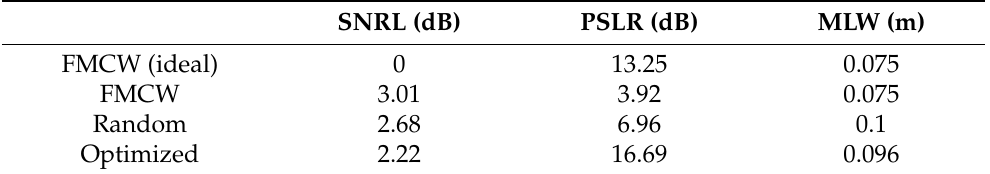
Table 2. Performance comparison with different waveform when jamming parameters are known.